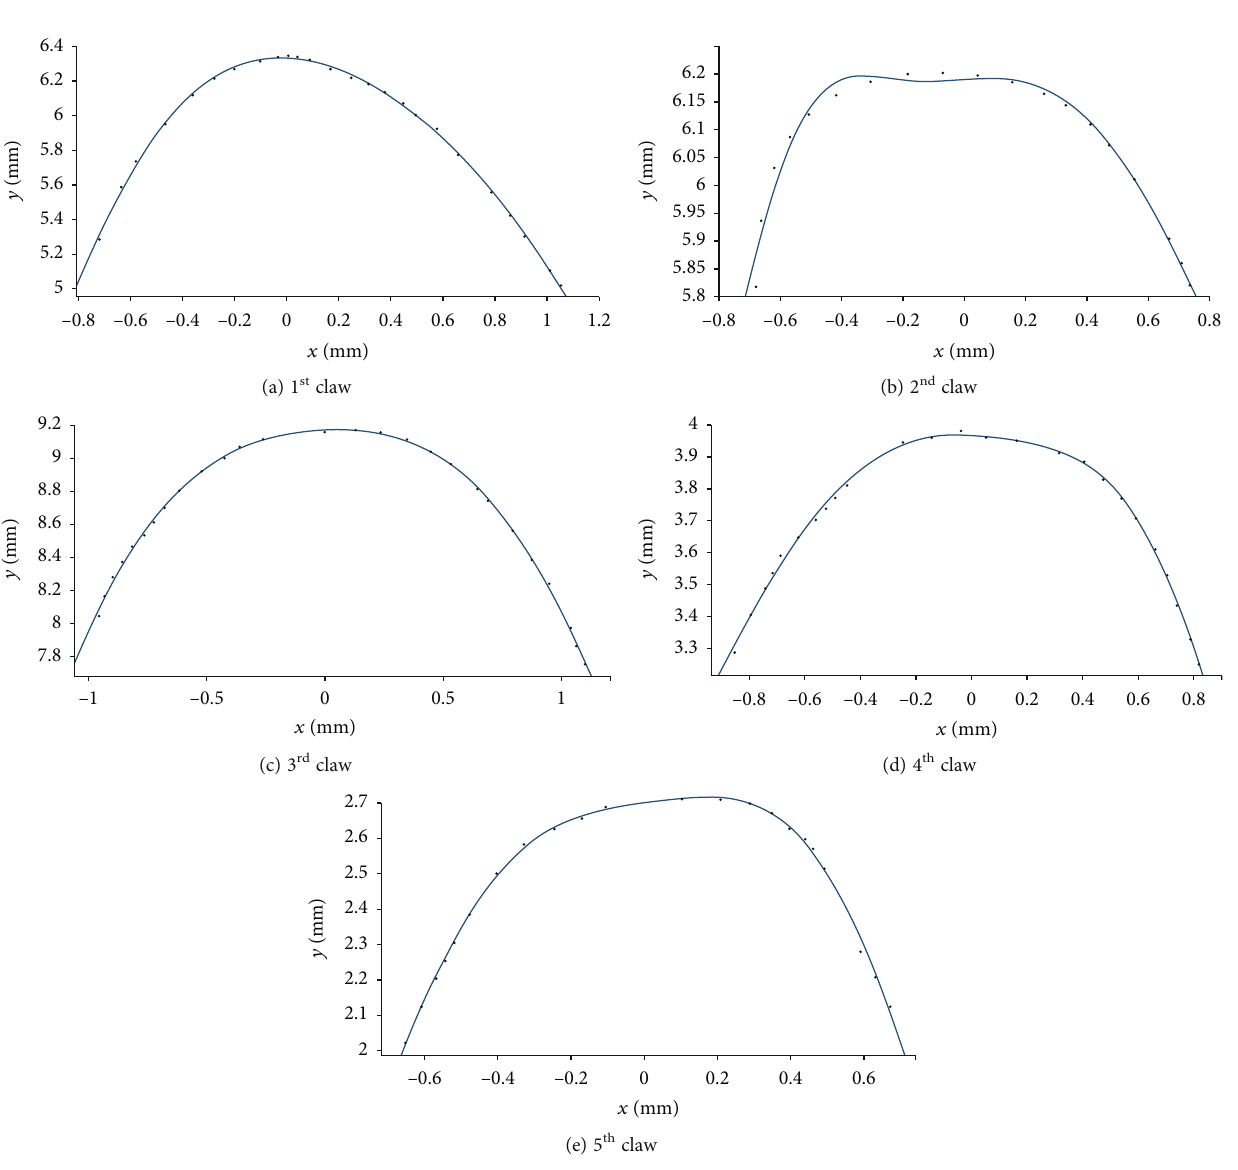
Figure 4: The fi tting curves of the fi ve claw tips of mole